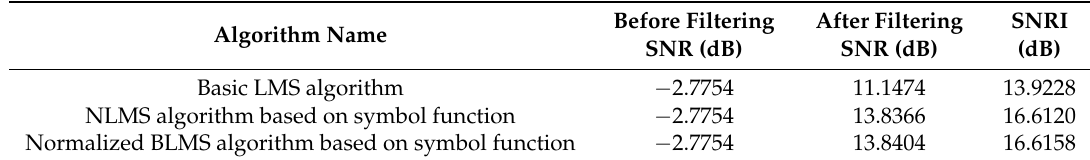
Table 5. SNR changes before and after denoising of ECG signals from the minicollector with BW